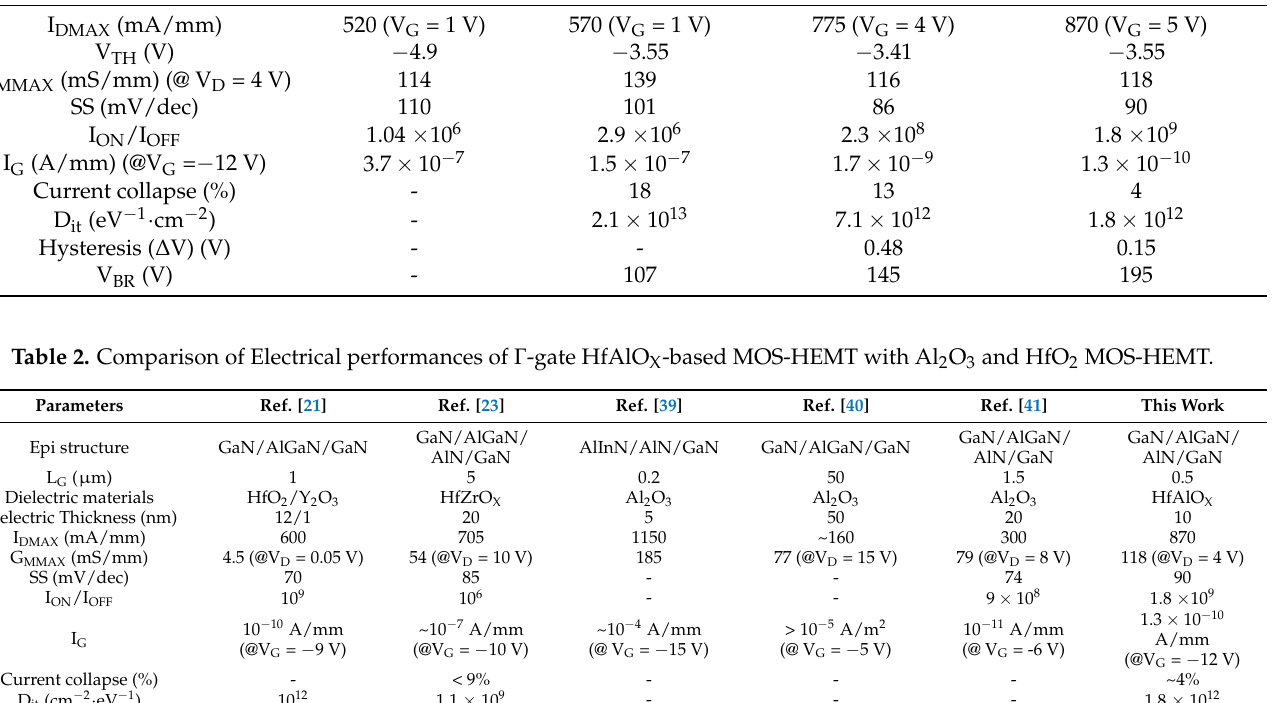
Non-Recessed Partially-Recessed Partially-Recessed Partially-Recessed HEMT HEMT HfO 2 MOS-HEMT